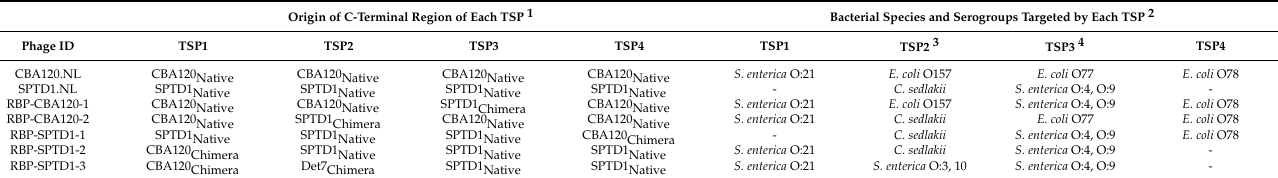
Table 1. Summary of Phage Design and Observed TSP